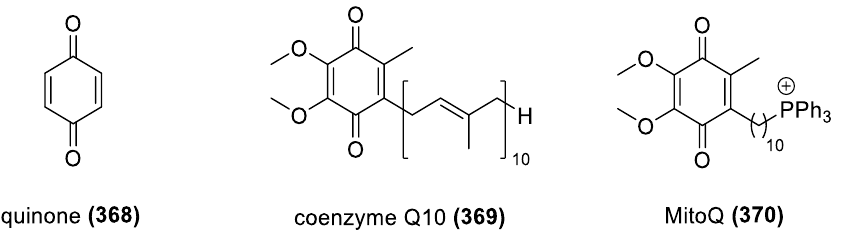
Figure 26. Structure of quinone, coenzyme Q10, and MitoQ.